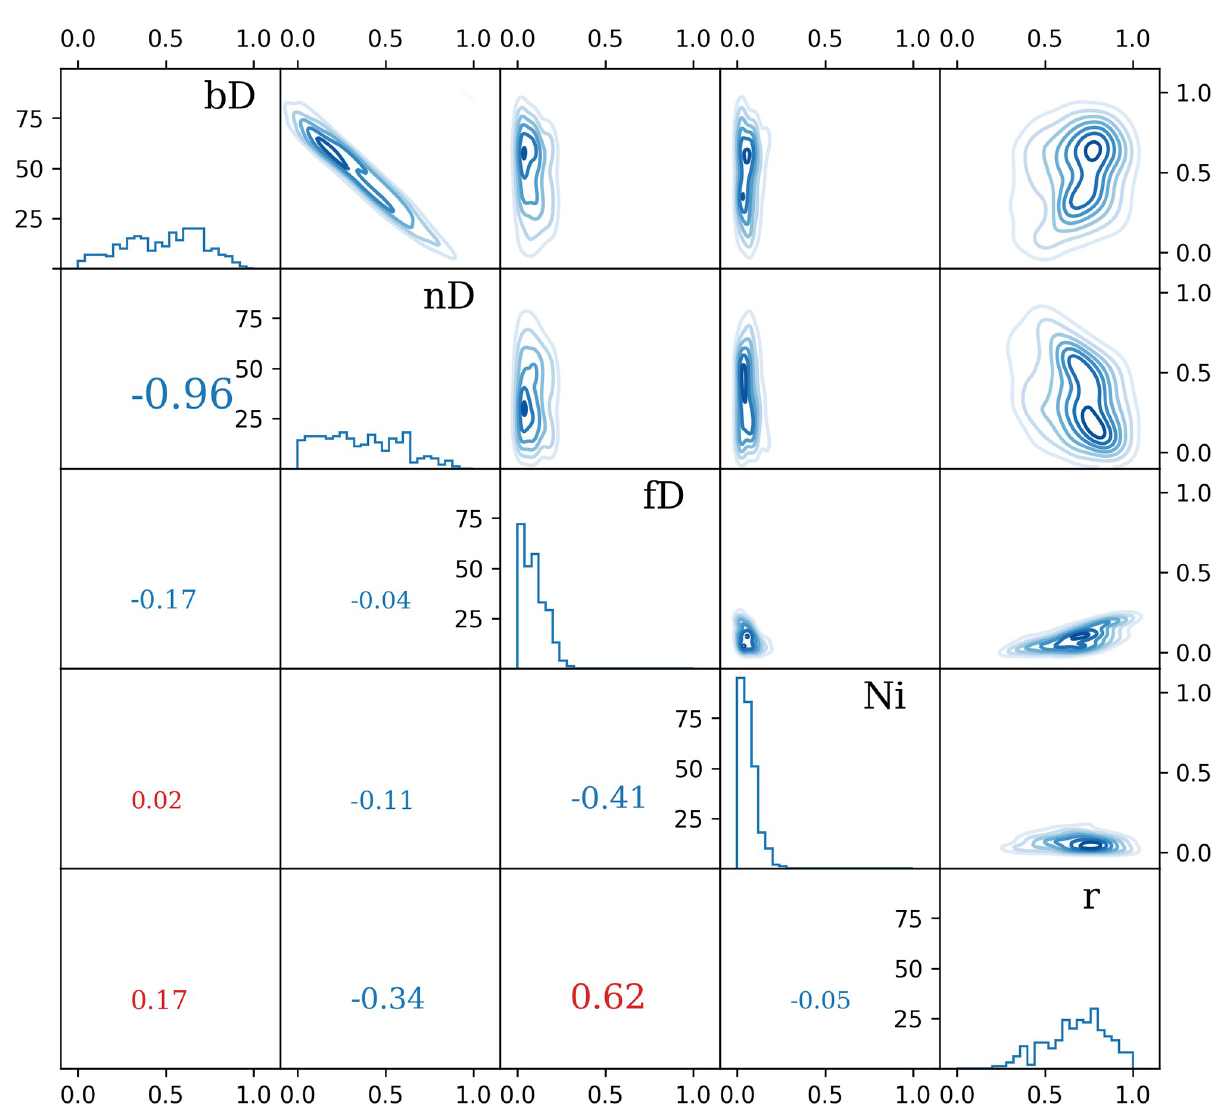
Fig 11. Distributions and correlations of random variables f and r that constitute the Markov chain. The histograms present the probability i distribution for mixing fractions ( f ) and residual fraction ( r ), right side graphs show the correlations of respective fractions and left side values indicate R values for these correlations. Sample 2 is